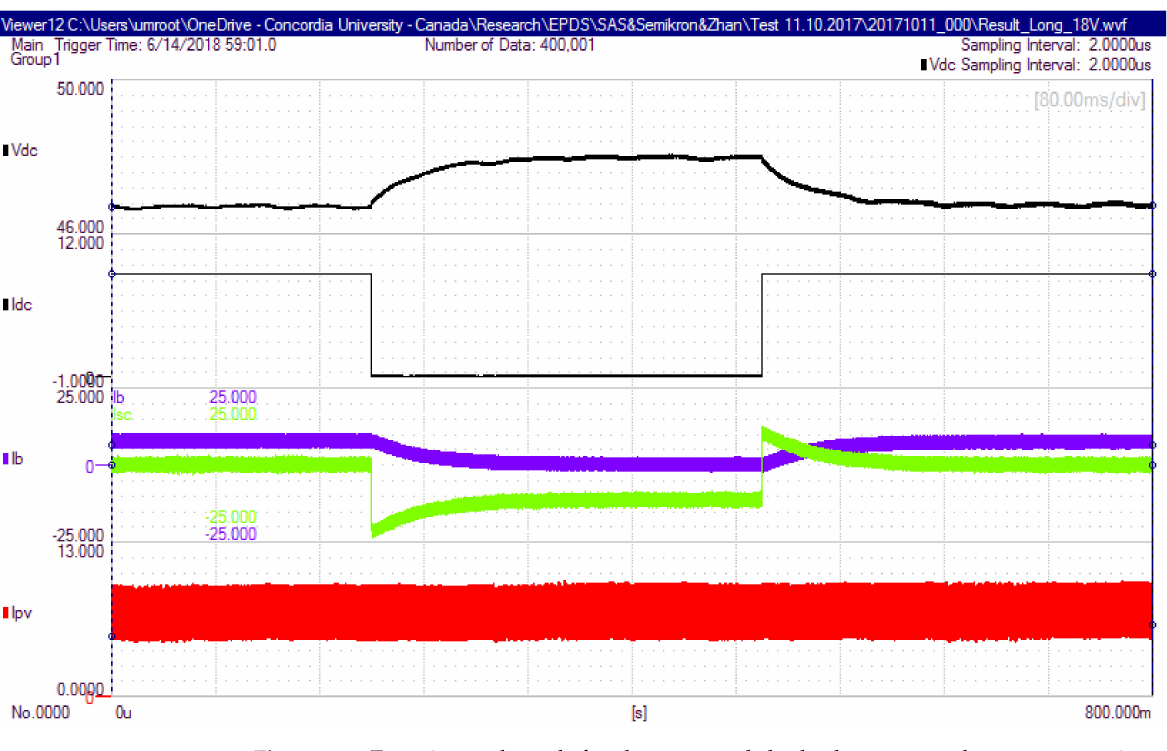
Figure 14. Experimental result for the proposed dual scheme control at supercapacitor voltage V SC = 18 V when the load changed from 5.2 Ω to no-load and back to 5.2 Ω